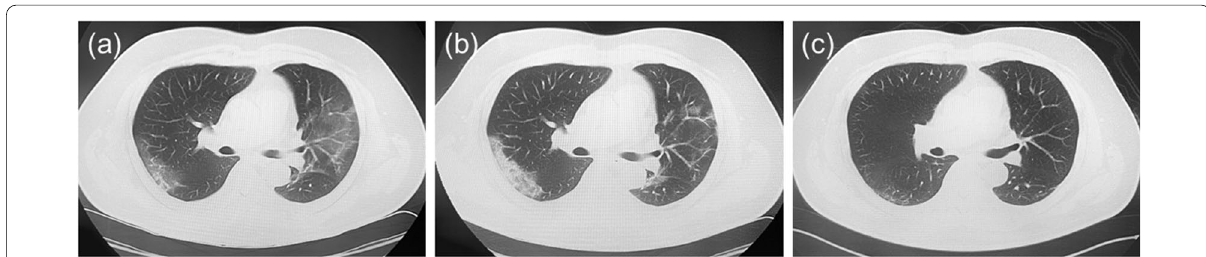
Fig. 2 Chest computed tomography (CT) images. a CT image 5 days after onset of symptoms. Bilateral ground-glass opacities (GGOs) were observed with lower-lung predominance. b CT image taken 11 days after onset, showing slightly elevated CT values of GGOs. c CT image taken 54 days after onset, showing the disappearance of